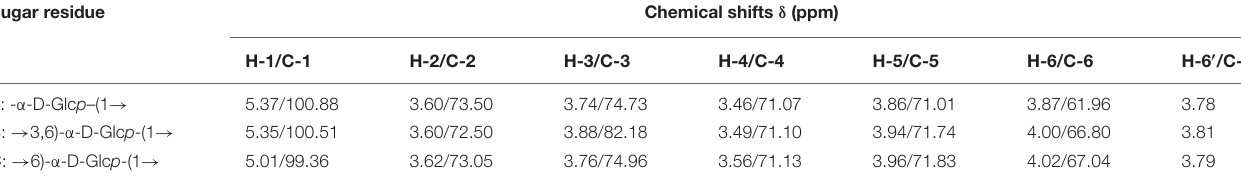
TABLE 3 | 1 H and 13 C NMR chemical shift data for EPS-F2.